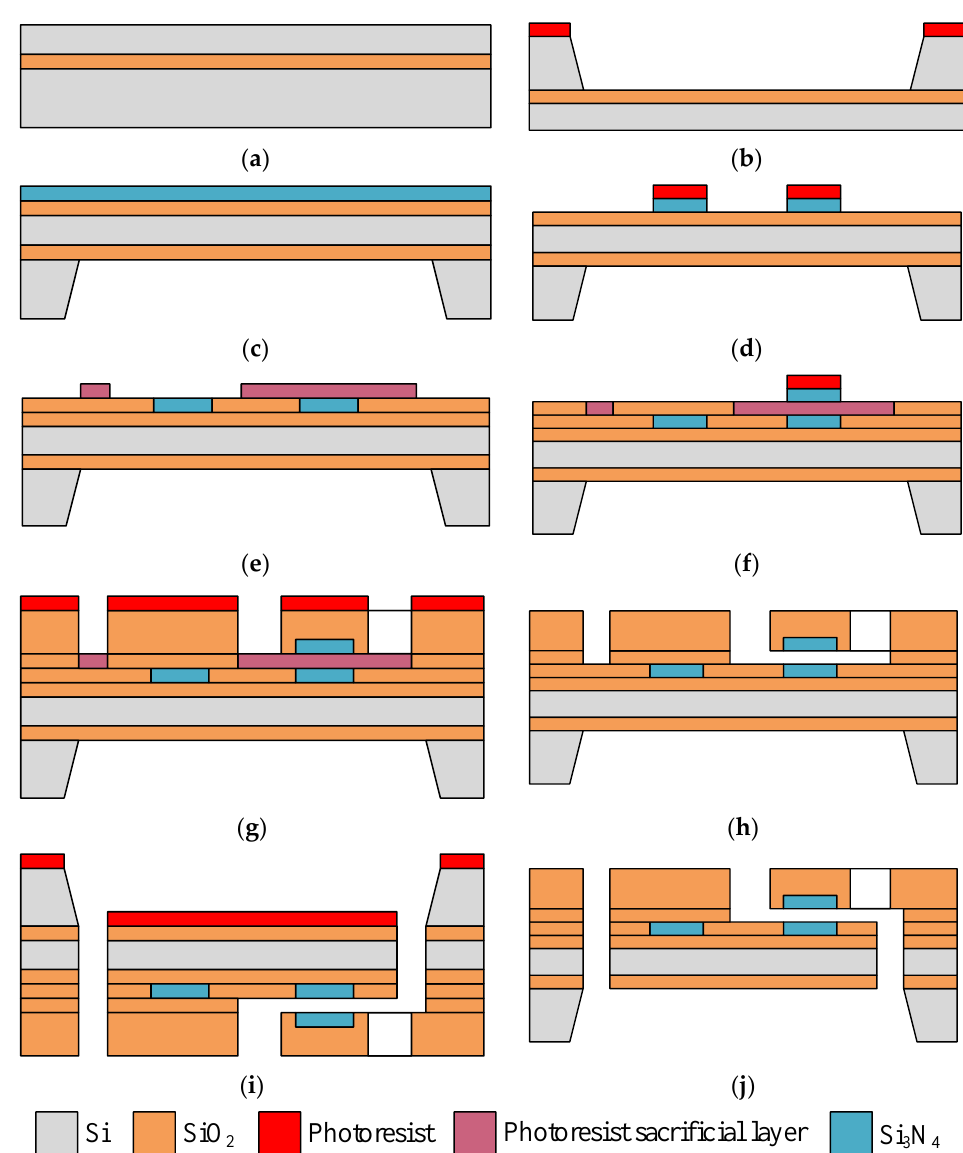
Figure 3. Technological scheme of MOEM-accelerometer fabrication with different–plane waveguides. ( a ) SOI wafer; ( b ) Etching of SOI wafer handle layer; ( c ) Deposition of Si 3 N 4 and SiO 2 layers; ( d ) Formation of moving Si 3 N 4 waveguides; ( e ) Deposition and smoothing of SiO 2 , formation of photoresist sacrificial layer; ( f ) Formation of Si 3 N 4 fixed waveguides; ( g ) Deposition of SiO 2 covering layer; ( h ) Photoresist sacrificial layer removal; ( i ) Etching of SOI BOX layer, device layer and SiO 2 ; ( j ) Photoresist removal.